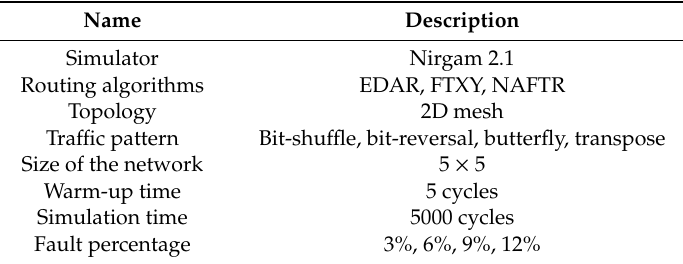
Table 3. Simulation parameters.